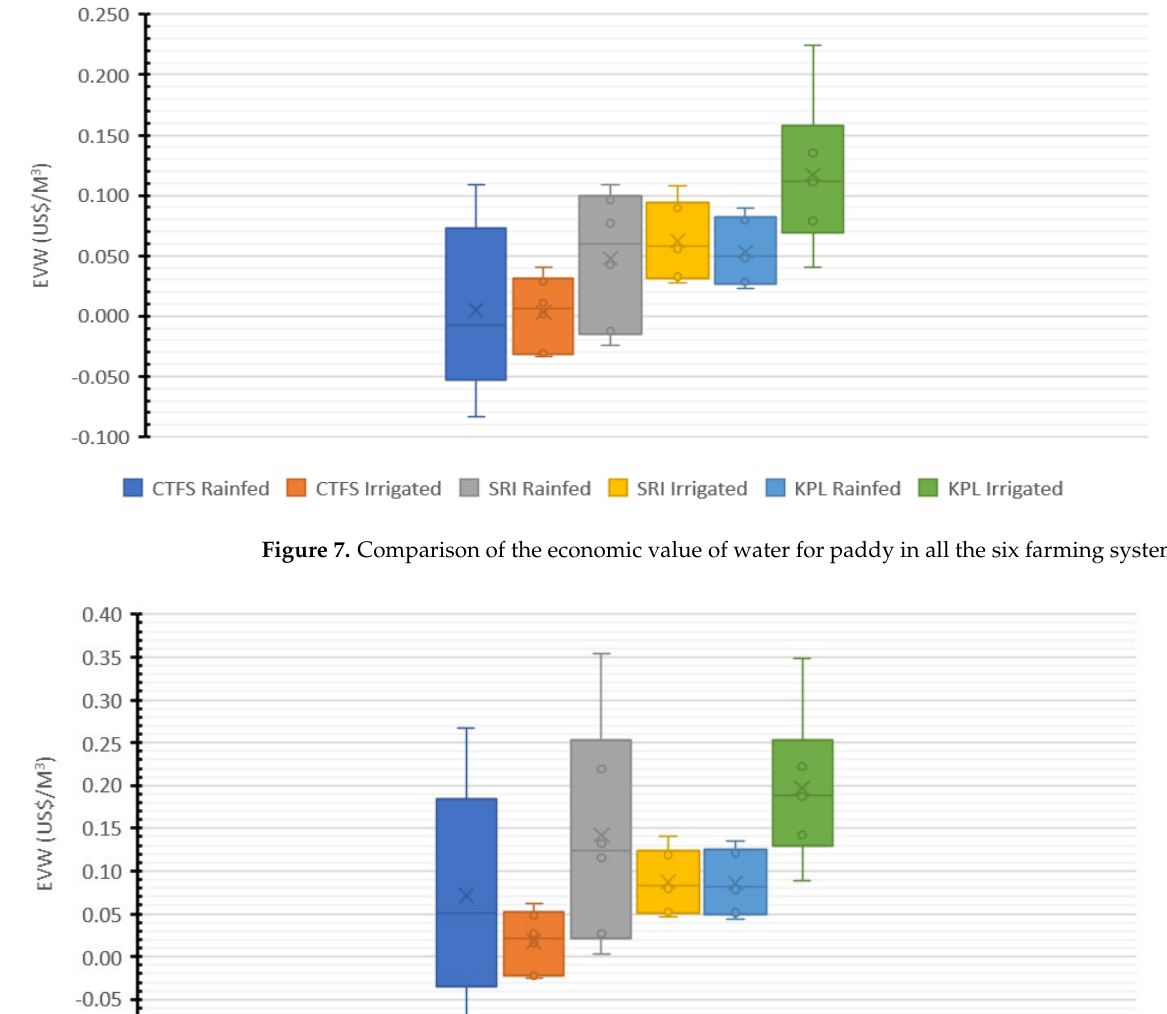
Table 5. Summary of descriptive economic value of water with other inputs of production.